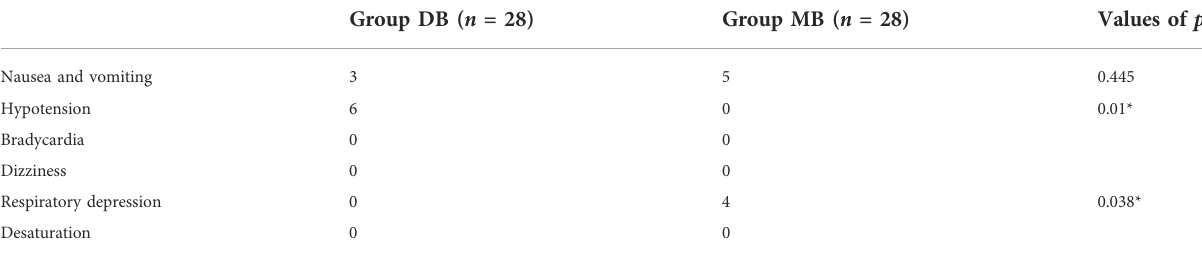
TABLE 4 Side effects of the two study